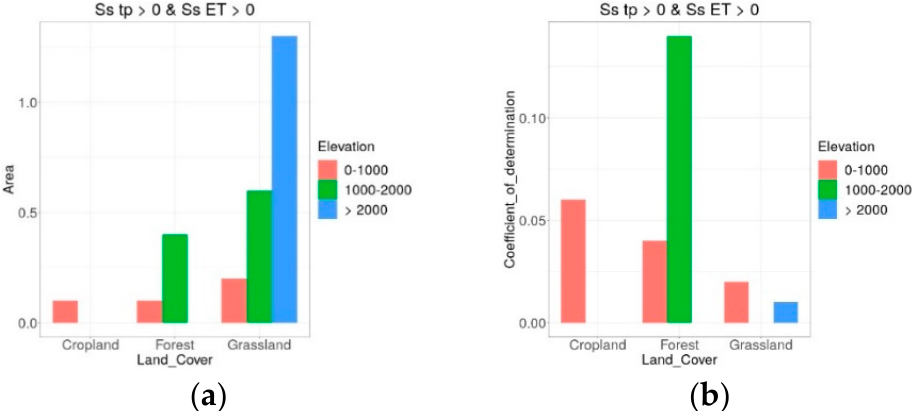
Figure 13. Percentage of area in each land cover class where tp and MOD16 ET trends overlap, per elevation ( a ) and corresponding r 2 ( b ). The combination of positive or negative ET and tp trends is indicated in the title of each plot. “Area” on the y axis is the percentage of the total area within each land cover class. Ss is the Sen’s slope of the trend at 5% significance from 2003 to 2019.